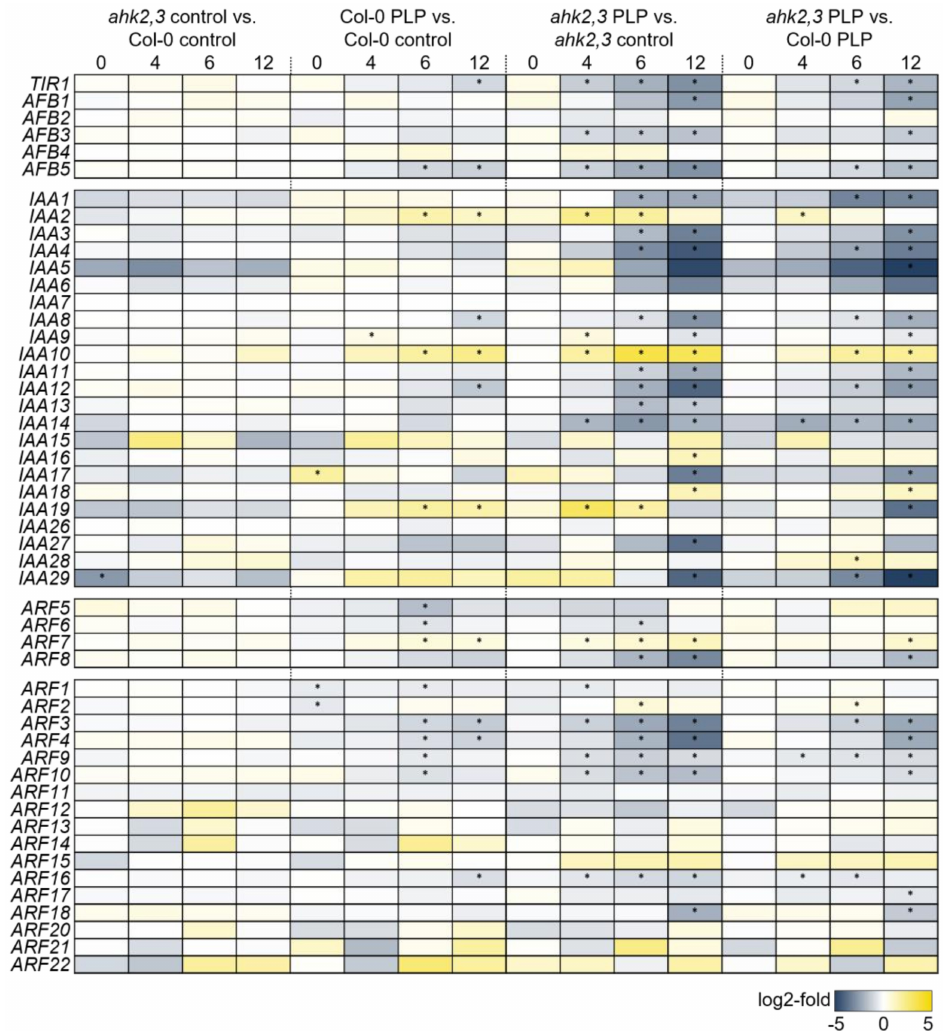
Figure 2. Relative expression of auxin signaling genes in response to photoperiod stress in wild type and ahk2,3 . Depicted are the relative expression of TRANSPORT-INHIBITOR-RESISTANT 1 ( TIR1 )/ AUXIN SIGNALING F-BOX (AFB), Aux / IAA and AUXIN RESPONSE FACTORs ( ARFs ) (class A ARFs, transcriptional activators, first group; class B and C, transcriptional repressors, second group) 0, 4, 6 and 12 h after the PLP compared to respective control plants. Stars indicate a significant difference between the indicated genotypes/conditions ( p ≤ 0.05; n = 3; log 2 -fold values are depicted in Supplementary Table S2). Data were extracted from